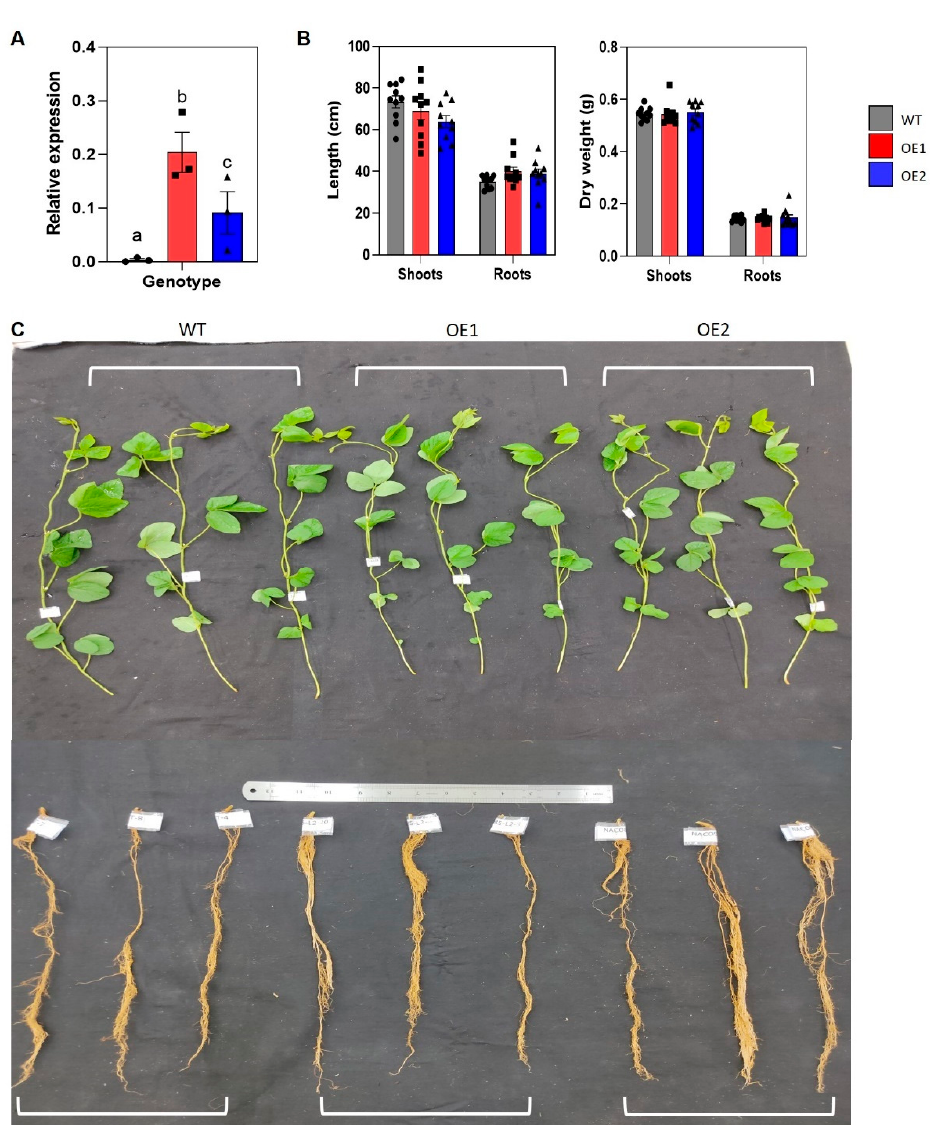
Figure 2. Expression of GmNAC085 in 21-day-old GmNAC085 -transgenic plants (OE1 and OE2) and their phenotype under normal growth conditions. ( A ) GmNAC085 expression levels in wild-type (WT), OE1 and OE2 plants ( n = 3). ( B ) Phenotypic parameters, including shoot length, root length, shoot dry weight and root dry weight ( n = 10). ( C ) Representative pictures of shoots and roots of the WT and transgenic plants. Each value represents the mean ± SE. Significant differences analyzed by ANOVA and Tukey’s honestly significant difference test were indicated by different letters ( p < 0.05).